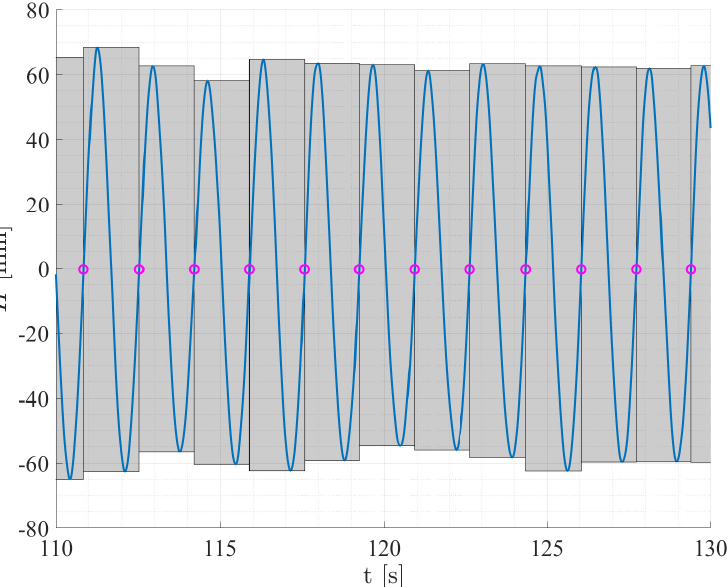
Figure 12. Visual representation of the zero-up crossing method. Pink circles represent every time the signal crosses zero from negative to positive. The width of the greyed areas indicates the wave period and the height indicates the wave height.